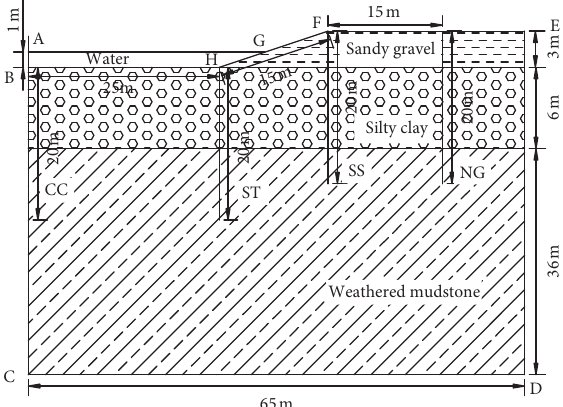
Figure 2: Ground temperature boreholes drilled at one side of the channel (unit: